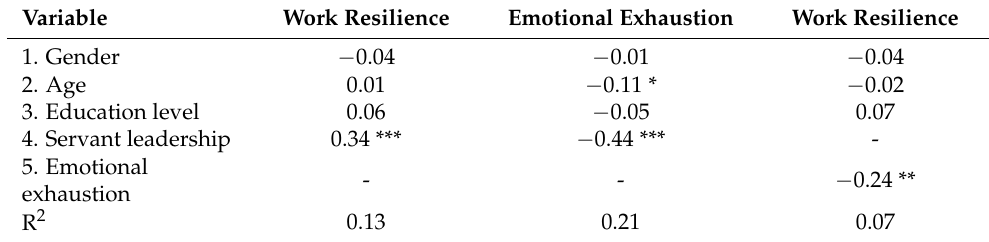
Table 4. Hierarchical linear regression.